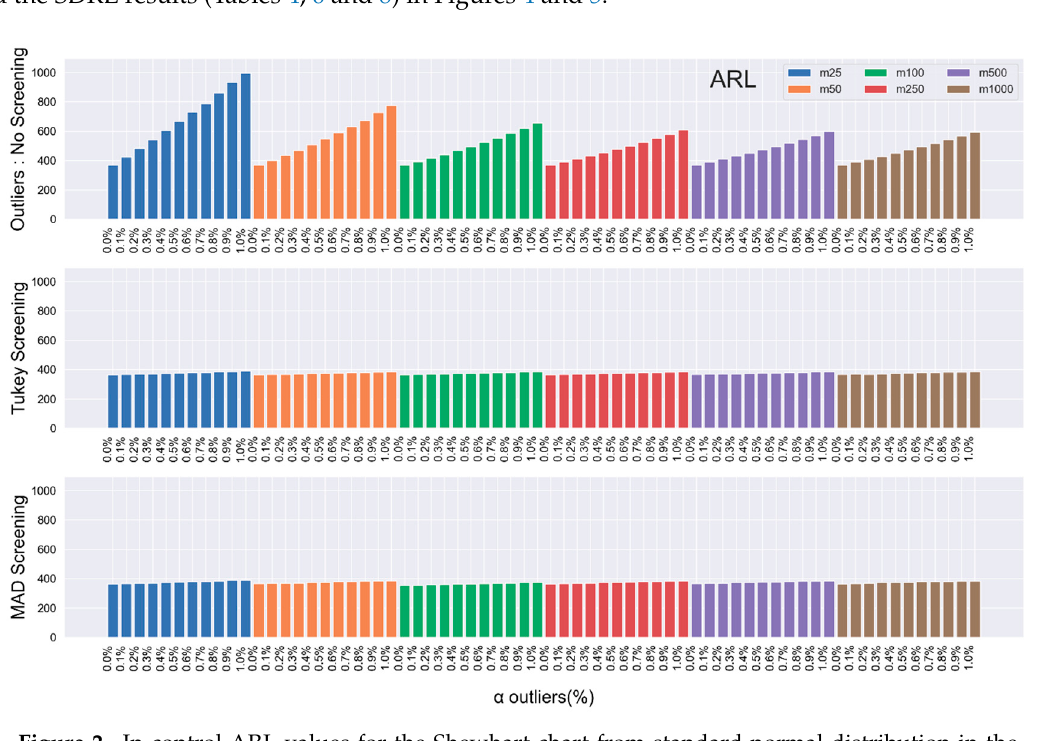
Figure 2. In-control ARL values for the Shewhart chart from standard normal distribution in the presence of outliers with and without outlier screening.